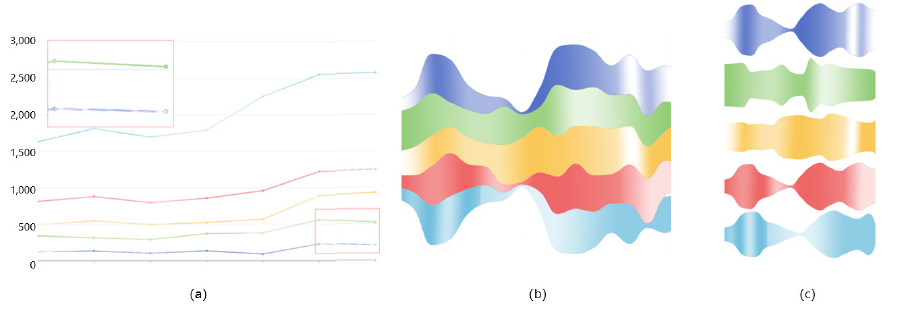
Figure 8. Three visual methods for comparing pockets. ( a ) Line Chart. ( b ) River Chart. ( c ) Deformed River Chart.